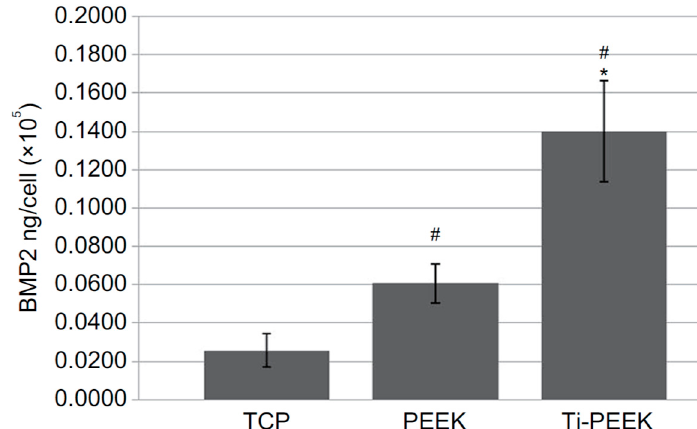
Figure 8. BMP-2 protein levels secreted by MG63 cells cultivated on Ti-PEEK, PEEK, and TCP surfaces. TCP: tissue culture plastic. * denotes p < 0.05 vs PEEK; # implies p < 0.05 vs TCP. Reproduced